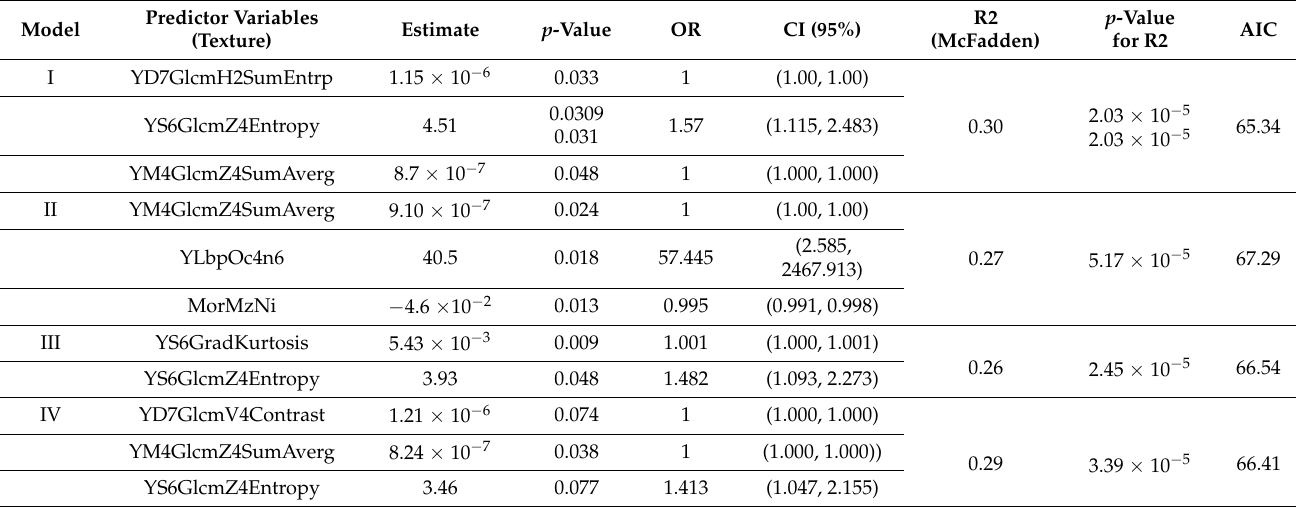
Table 2. Comparison of built logistic regression